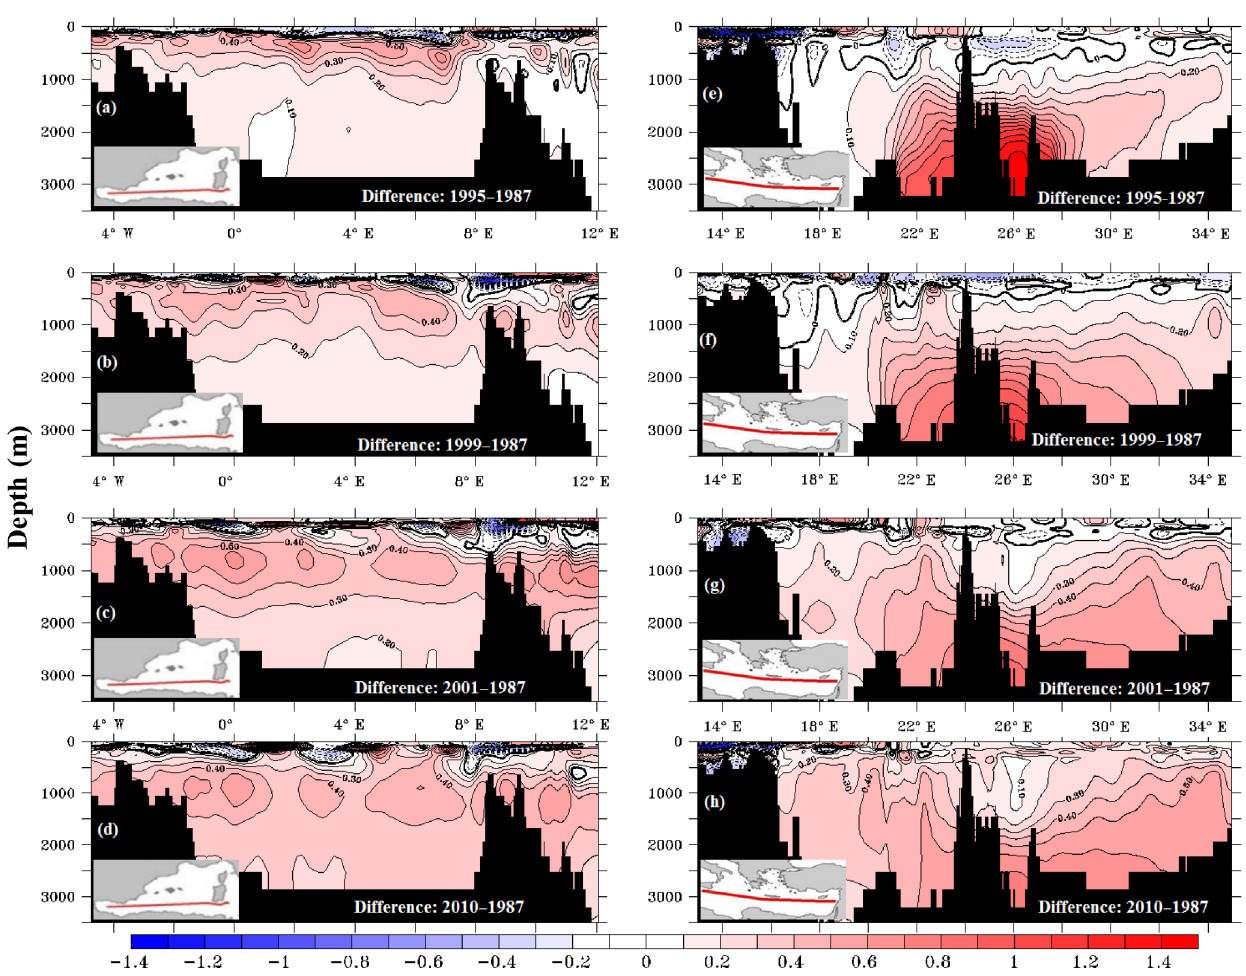
Figure 9. Colour-filled contours represent simulated Nd isotopic composition for the WMed in the left column, and the EMed sections are shown in the right column. The first line show the situation in 1987 (pre-EMT), the others sections show the difference in the Nd-IC between 1995 and 2010 (post-EMT period) corrected to the 1987